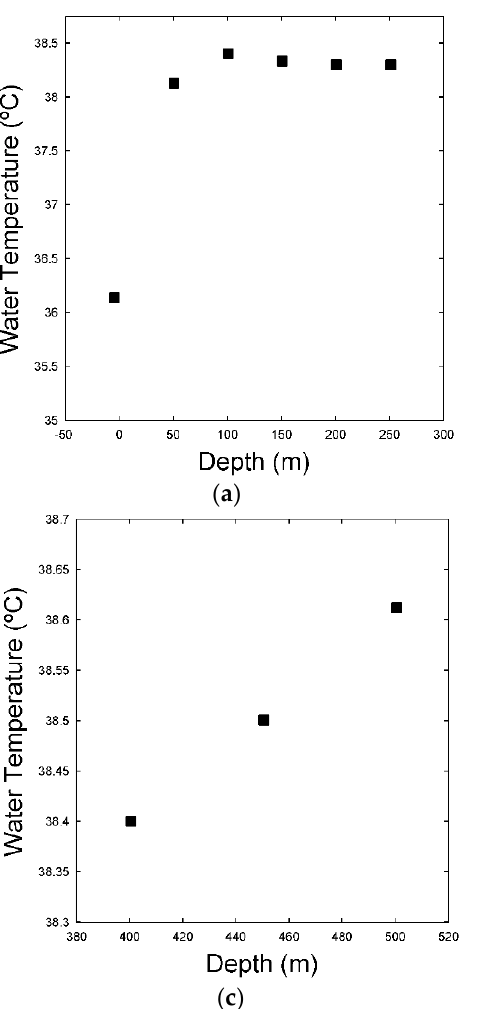
Figure 6. Fluid temperature profile. ( a ) The graph was stretched out from 0 m to 250 m; ( b ) The graph was stretched out from 300 m to 500 m; ( c ) The graph was stretched out from 400 m to 500 m; ( d ) The graph was stretched out from 600 m to 690 m.